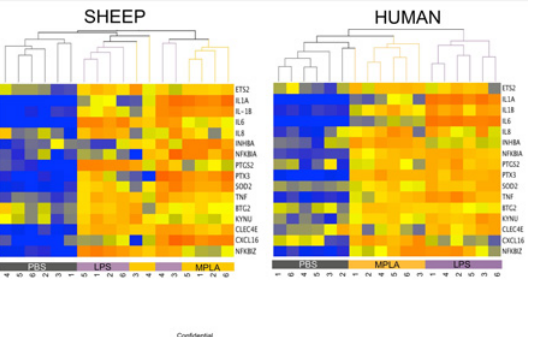
Fig 3. Hierarchical cluster of the 16 sheep-human orthologues (16 probes in both sheep and human) similarly expressed in both species ( > 1.5-fold, paired t-test p-values < 0.05). Intensity values are normalized to the mean expression within each subject. Red/Orange: high expression relative to median; yellow: mean expression; and blue: low expression relative to median.